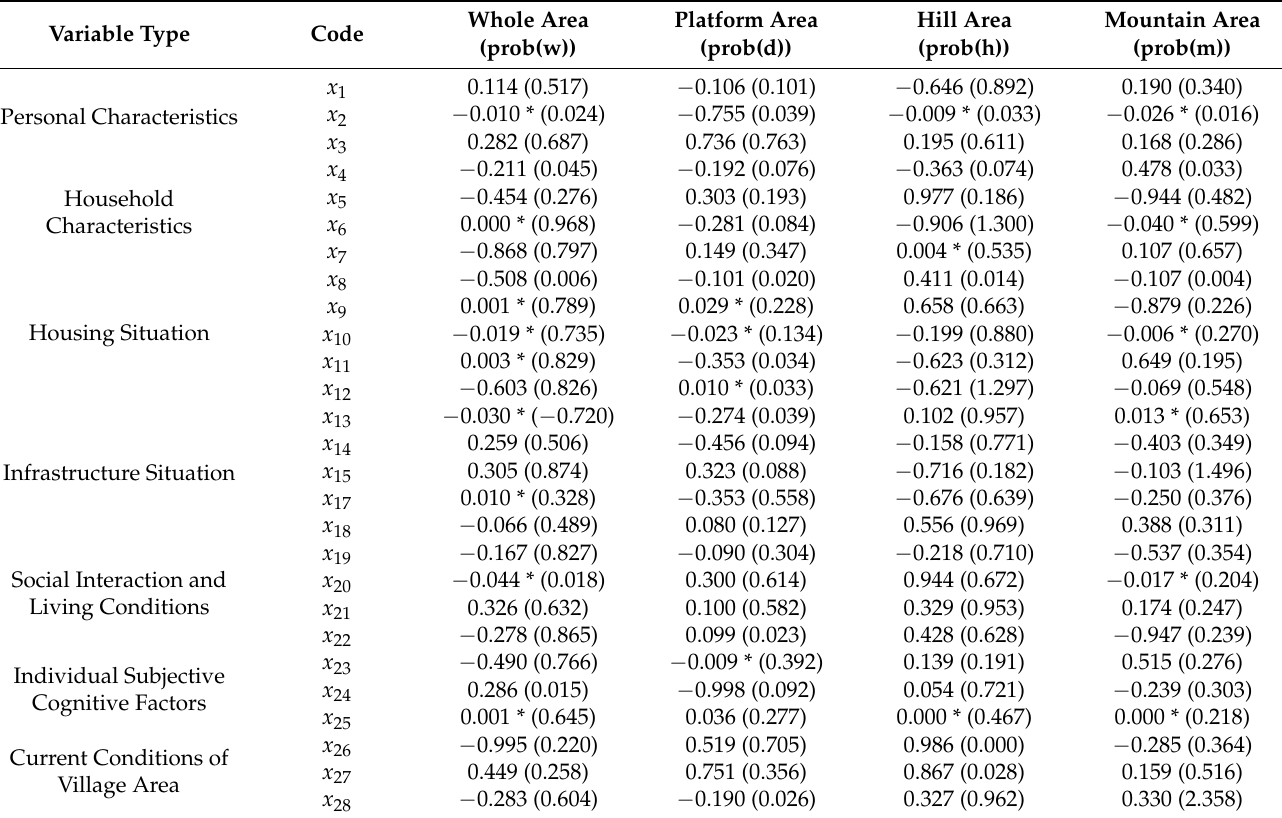
Table 4. Regression results of logistic model parameters of farmers’ homestead agglomeration in different